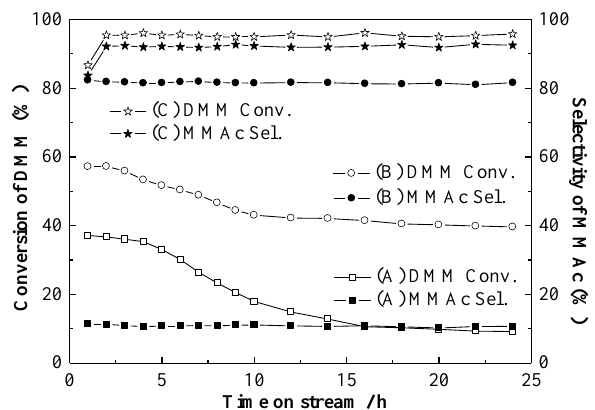
Figure 8. The catalytic stability of HY (A), HY-H 4 EDTA-NH 4 OH (B), and HY-H 4 EDTA-NH 4 OH-TPAOH (C) for 24 h reaction. Reaction conditions: catalyst weight, 1.0 g; reaction temperature, 100 °C; reaction pressure, 5.0 MPa; total CO flow rate, 100 mL/min; time on stream, 24 h.